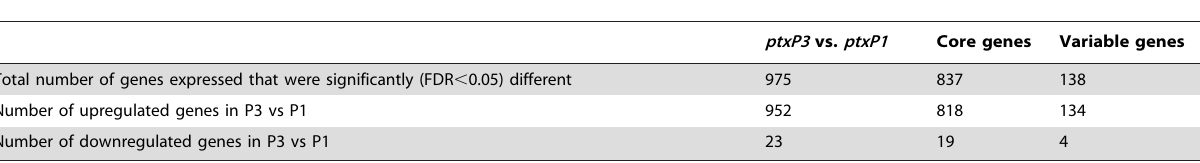
Table 1. Differentially expressed genes in ptxP3 vs. ptxP1 Bordetella pertussis strains.